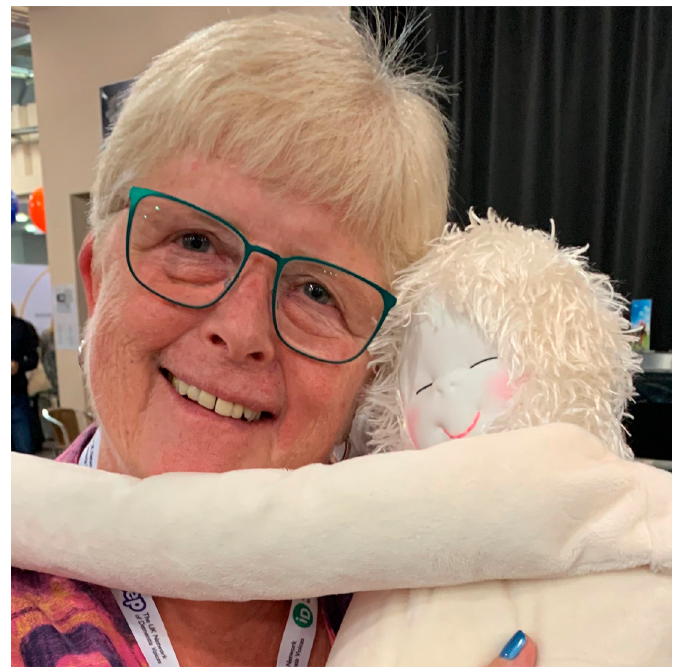
Figure 3. Person living with dementia holding a prototype HUG. Photo C. Treadaway.